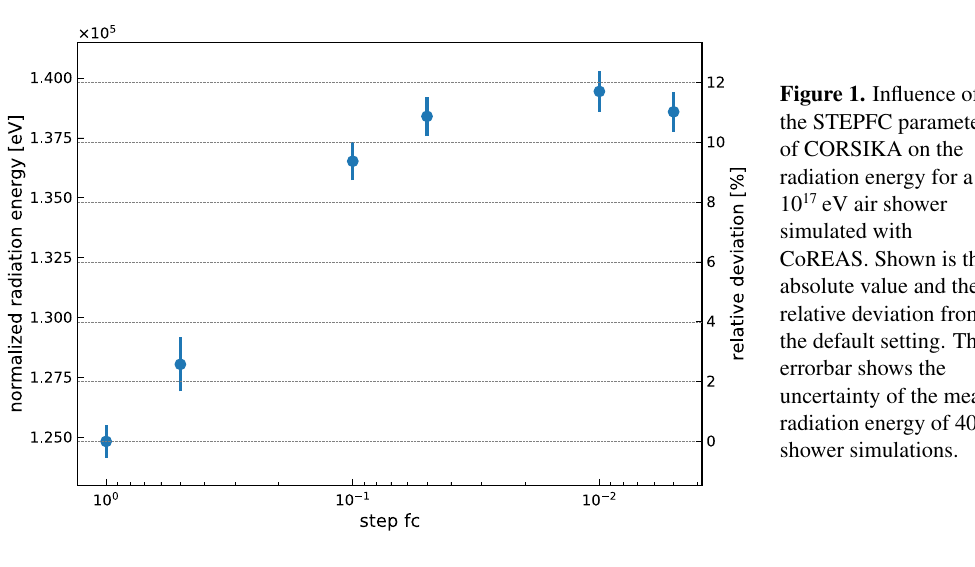
Figure 1. Influence of the STEPFC parameter of CORSIKA on the radiation energy for a 10 17 eV air shower simulated with CoREAS. Shown is the absolute value and the relative deviation from the default setting. The errorbar shows the uncertainty of the mean radiation energy of 40 air shower